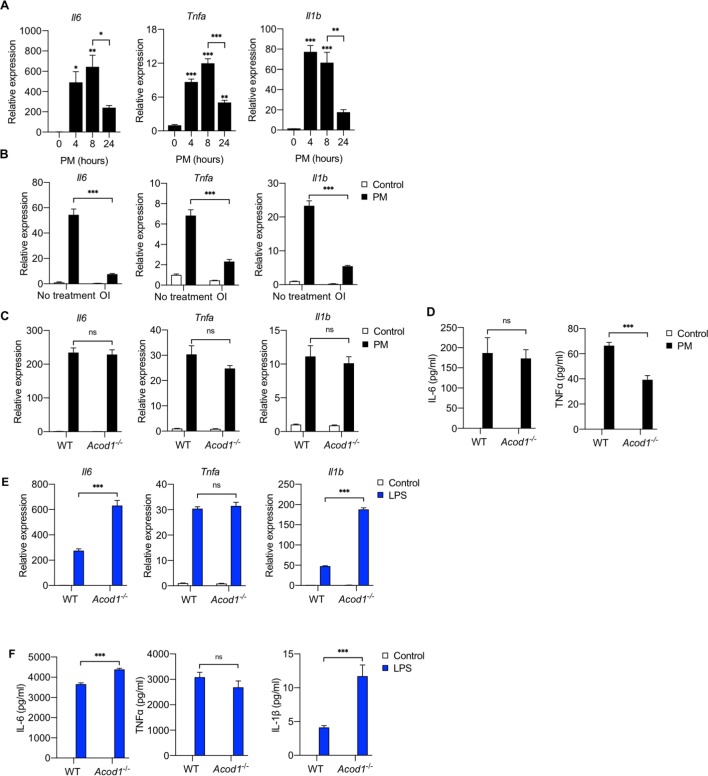
Exogenous but not endogenous itaconate decreases PM-induced inflammation.(A) We treated WT BMDMs with PM for 4, 8 or 24 hours and measured mRNA expression of Tnfa, Il6 and Il1b by qPCR (n = 3). (B) We pretreated WT BMDMs with OI or vehicle control (DMSO) for 2 hours before we treated them with PM or vehicle control for 4 hours. We then measured mRNA expression of Tnfa, Il6 and Il1b (qPCR). (C, D) We treated WT and Acod1-/- BMDMs with PM or ve and measured (C) mRNA expression of Tnfa, Il6 and Il1b (qPCR). and (D) protein levels of IL-6 and TNFα in media (ELISA). IL-1β protein was not detectable. (E, F) We treated WT and Acod1-/- BMDMs with LPS (100 ng/ml) or PBS (control) and measured (E) mRNA expression of Tnfa, Il6 and Il1b (qPCR). and (F) protein levels of IL-6, TNFα, and IL-1β in media (ELISA, n = 4). Significance was analyzed with one-way ANOVA corrected with Bonferroni’s post hoc test for multiple comparisons *p<0.05, **p<0.01, ***p<0.001.